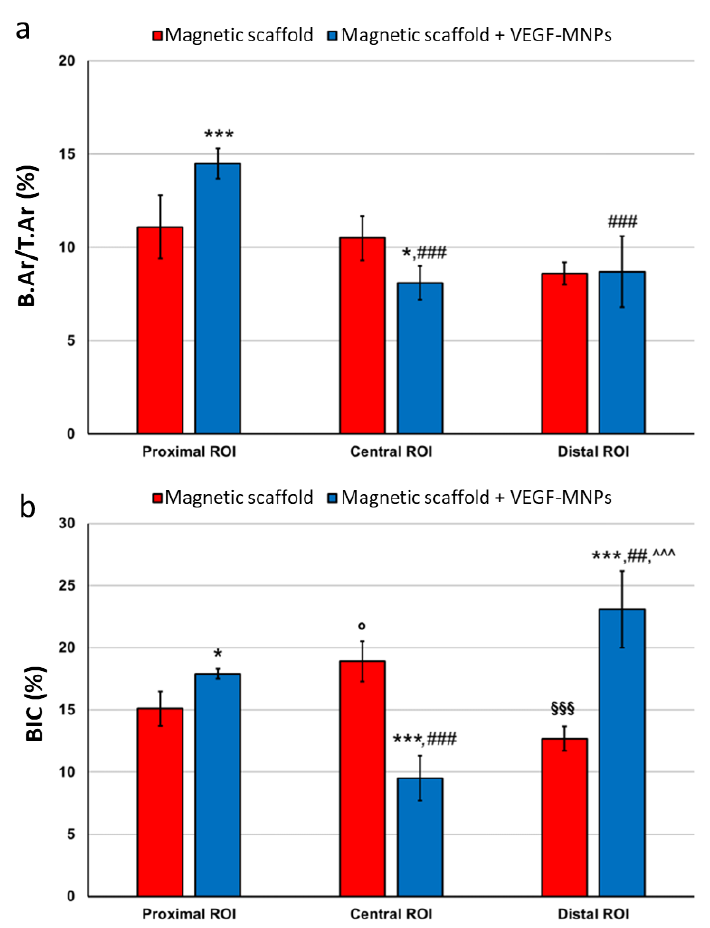
Figure 5. Bars of bone area/total area (%) (B.Ar/T.Ar) and BIC (%) of magnetic scaffold + VEGF-MNPs group and magnetic scaffold group measured in the proximal, central and distal ROIs. Two-way ANOVA showed significant interactions of selected factors (treatment and ROI) on B.Ar/T.Ar (F = 9.40, p = 0.002) and BIC (F = 29.09, p < 0.0005). Pairwise comparison test (1 symbol: p < 0.05; 2 symbols: p < 0.005; 3 symbols: p < 0.0005); *, magnetic scaffold + VEGF-MNPs group versus magnetic scaffold group; °, central and distal ROIs versus proximal ROI for magnetic scaffold group; #, central and distal ROIs versus proximal ROI for magnetic scaffold + VEGF-MNPs group; §, distal ROI ver- sus central ROI for magnetic scaffold group; ^, distal ROI versus central ROI for magnetic scaffold + VEGF-MNPs group. 2.3. AFM Nanoindentation In Figure 6, the variation in the Young’s modulus (E values) along the direction par- allel to the z -axis is shown together with the field values (B values) at the same distance from the z -axis. Remarkably, there is a variation in E along the z -axis with a minimum m = (0.025 ± 0.004) GPa at z = (3.32 ± 0.17) mm and a maximum M = (1.24 ± 0.18) GPa at z = (5.10 ± 0.17) mm; furthermore, a gradual decrease at higher z values was observed.